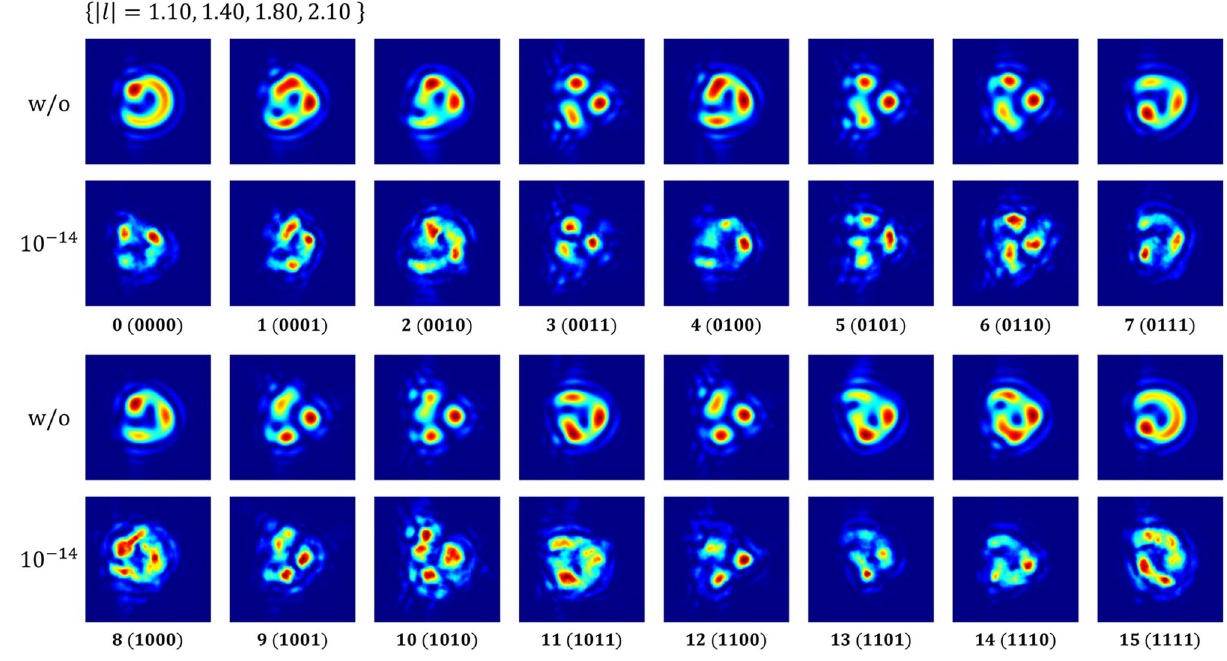
Figure 9. Intensity profiles of the received multiplexed fractional beams over 1000-m free-space channels with and without AT. Each label below a sub-image represents a 16-ary number and the bit string that corresponds to that number. In the presented scheme, 0 or 1 is assigned to each bit according to the sign of fractional OAMs constituting a superimposed mode.